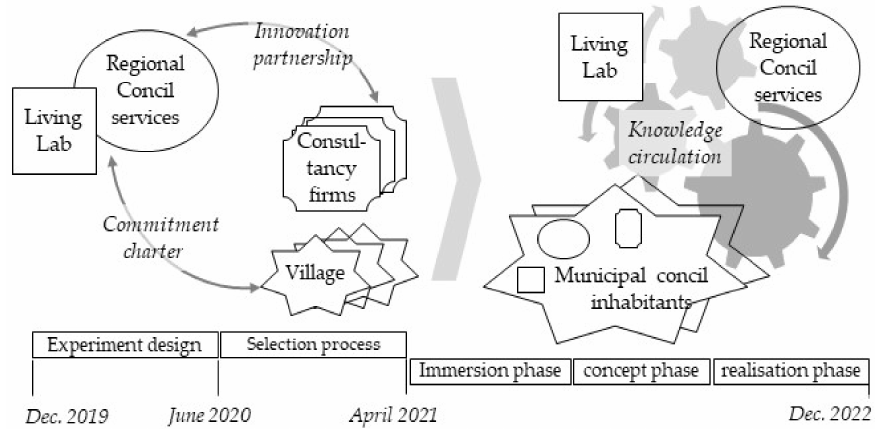
Figure 2. Methodology and process